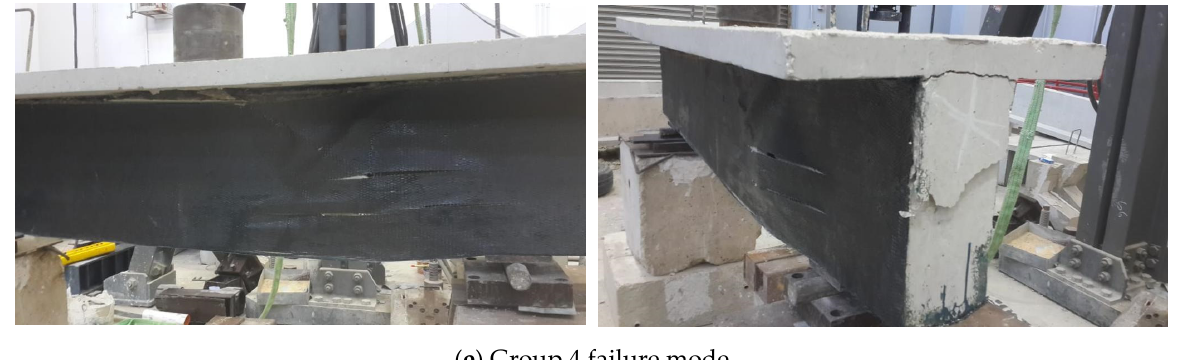
Figure 5. Failure modes of beams.